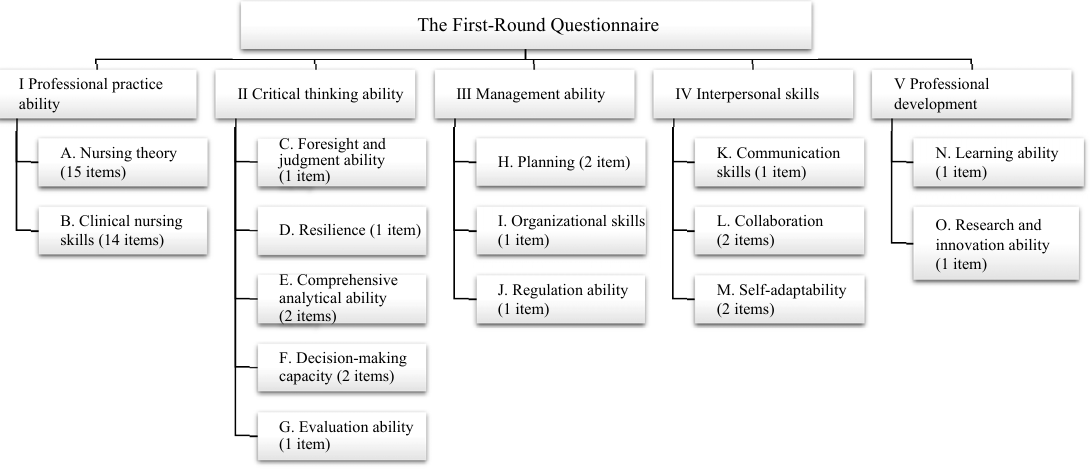
Figure 2. The first-round of modified Delphi